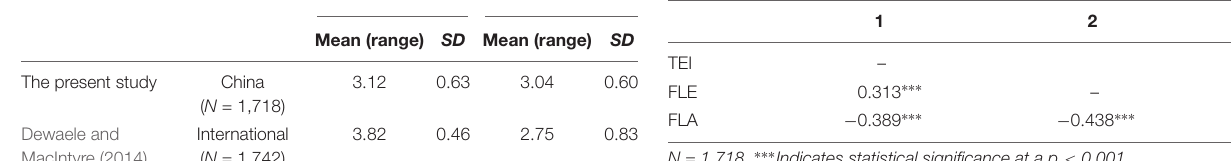
TABLE 3 | Comparisons of classroom emotions between the present study and the study by Dewaele and MacIntyre (2014).